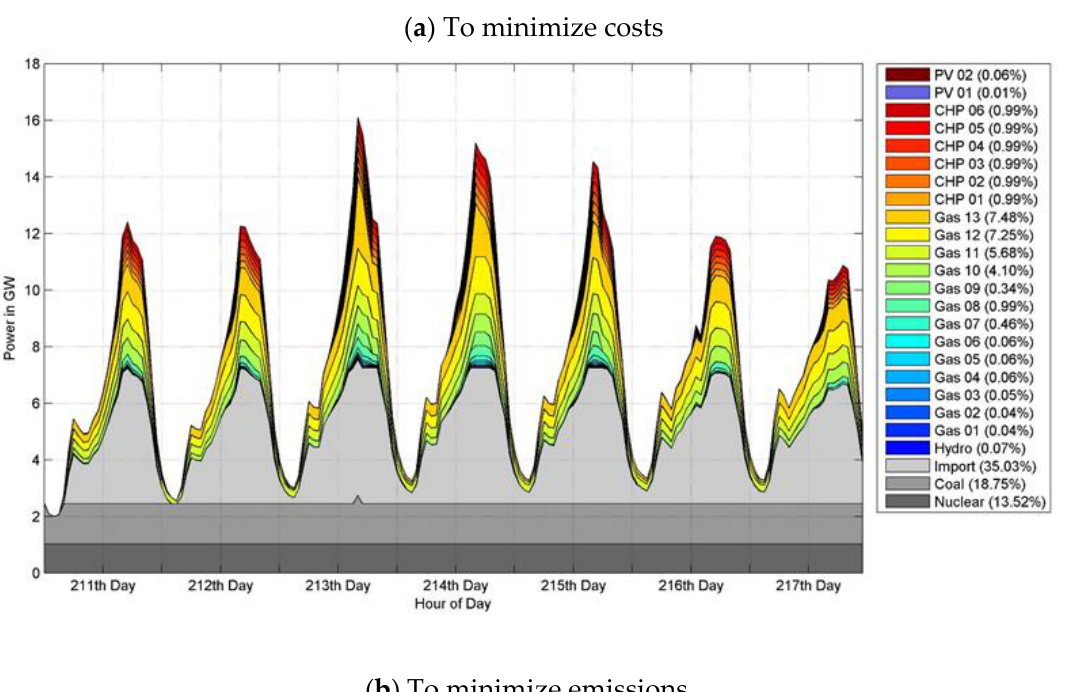
Figure 12. Weekly profile including the peak day for the Georgia state grid.